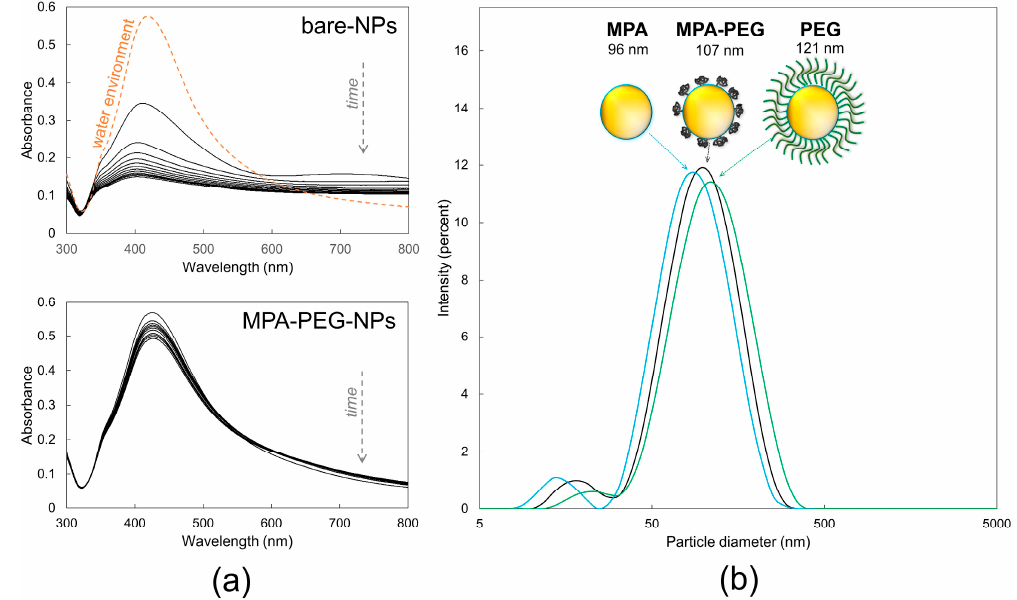
Figure 3. ( a ) The stability measurements of colloids (10 µg/mL) in a saline solution within 60 min. The spectra were collected every 5 min; ( b ) dynamic light scattering (DLS) measurements of the influence of PEG conformation on the particle size.